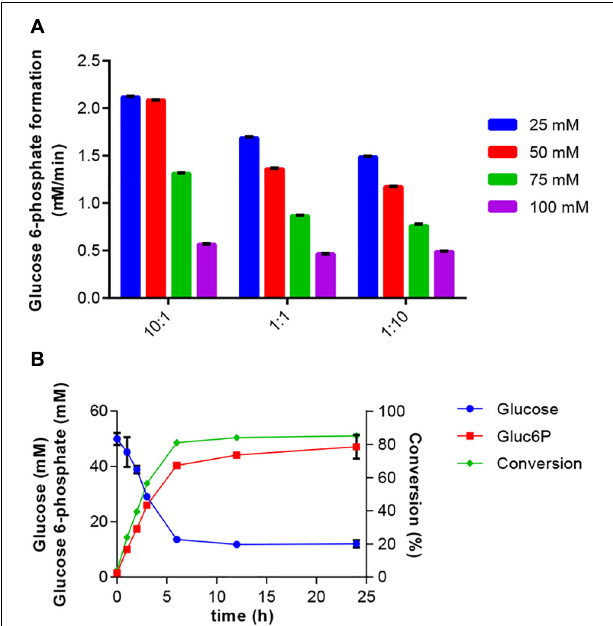
FIGURE 4 | Production of glucose 6-phosphate. (A) Effect of HK to PPK2 ratio on glucose 6-phosphate production at different glucose and polyphosphate concentrations. Enzyme ratios used were 10:1, 1:1, and 1:10 and were calculated based on V max values. The glucose 6-phosphate production was calculated after a 2 h reaction at 30 ◦ C. Glucose 6-phosphate production rate was determined using the coupled enzyme assay. (B) One-pot synthesis of glucose 6-phosphate production from glucose using HK and PPK2 activities. Reaction mixtures were incubated at 30 ◦ C and samples were taken at the indicated times. Produced glucose 6-phospate and remaining glucose were determined using HPAEC-PAD. Conversion indicates the fraction of glucose converted into glucose 6-phosphate. All data represent the mean and standard error of two or three replicates. If not visible, the error bar is smaller than the symbol size.